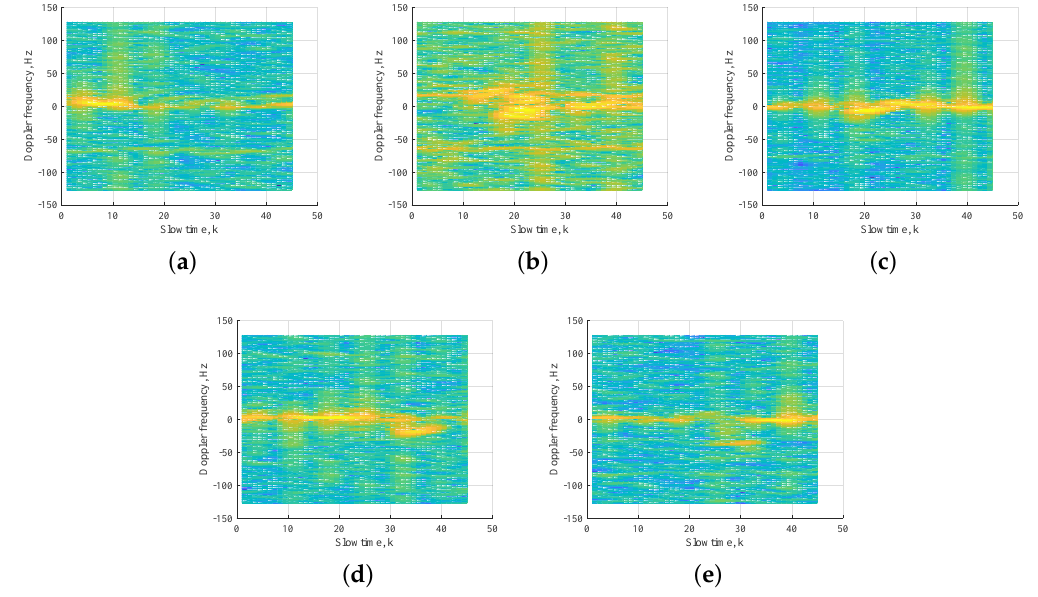
Figure 5. The examples of five finger gestures. ( a ) Finger close; ( b ) Finger clockwise; ( c ) Finger slide; ( d ) Finger open; ( e ) Finger